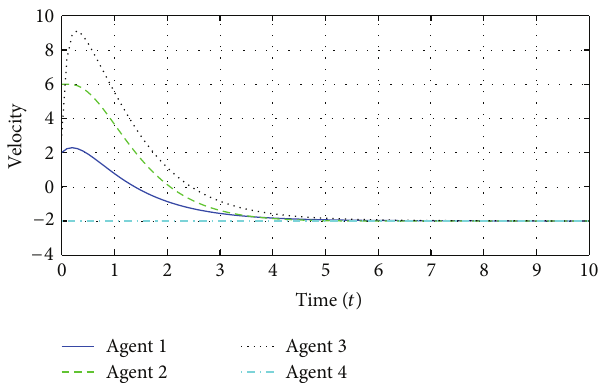
Figure 3: The evolution of velocity state V 𝑖 (𝑡) for 𝑖 = 1, ...,4 .